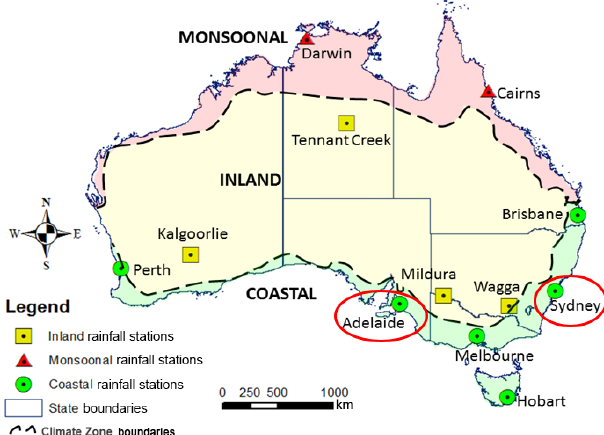
Figure 1. Location map of 12 rain gauge stations around Australia. This study has presented the assessment results of the developed models for Sydney and Adelaide stations (red circled) only. The shaded green, yellow, and red colours indicate the coastal, inland, and monsoonal areas,